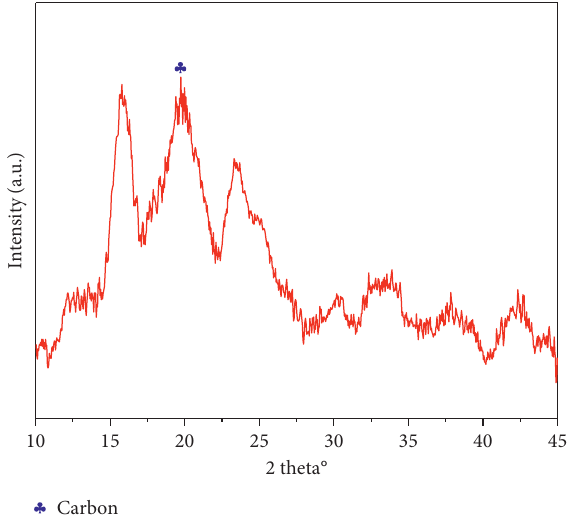
Figure 1: XRD pattern of RDP.